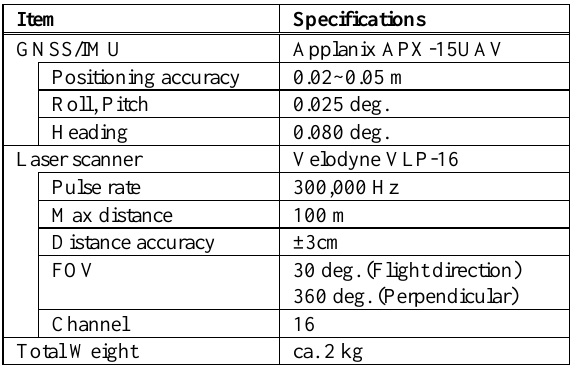
Table 2. Laser scanner specifications